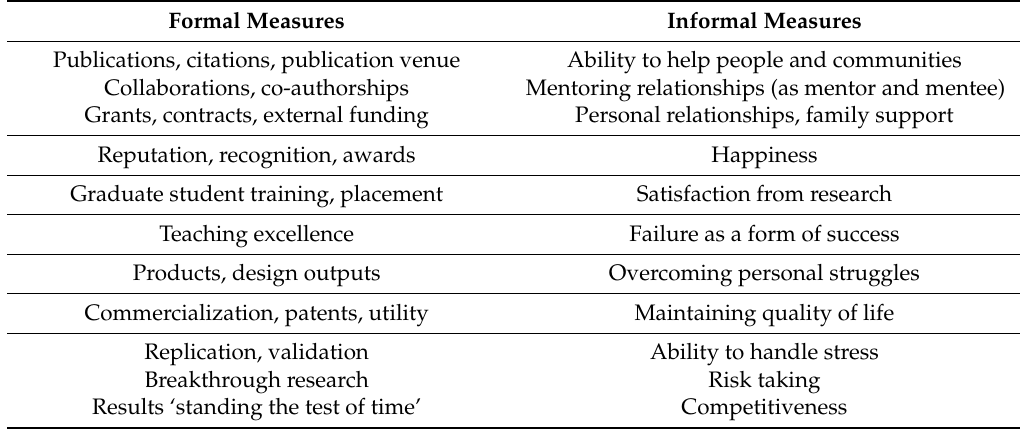
Table 2. Formal and informal measures in accounts of scientific